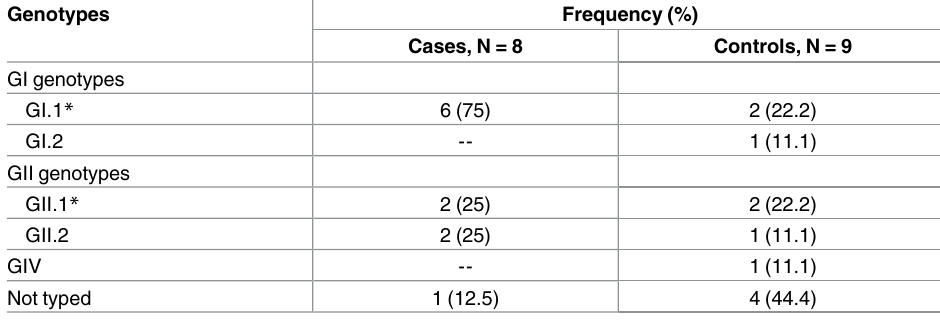
Table 4. Sapovirus genotype distribution among cases and healthy controls.